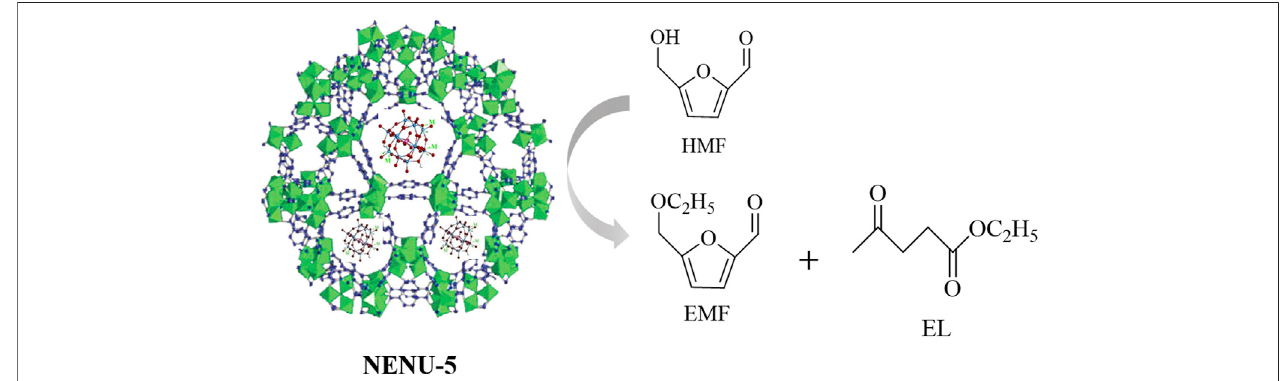
FIGURE 2 | Schematic illustration of the catalysis